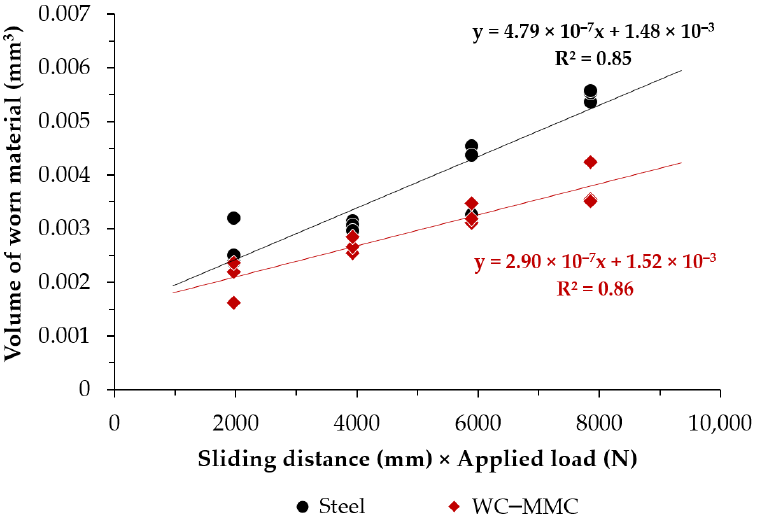
Figure 8. Volume of worn material as a function of the sliding distance under a constant load of 0.25 N for the WC – MMC and base